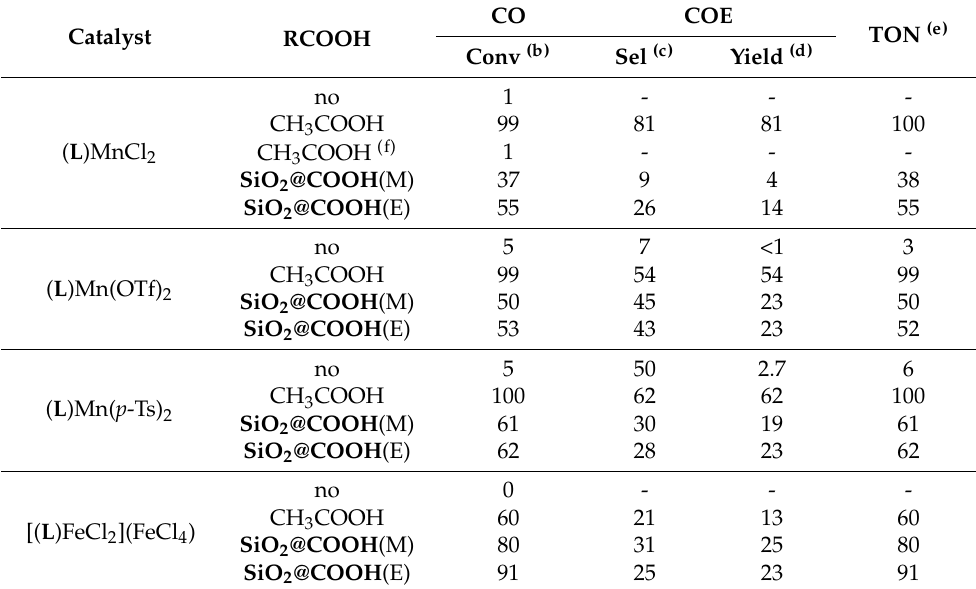
Table 4. Relevant data for the catalyzed epoxidation of CO (a)